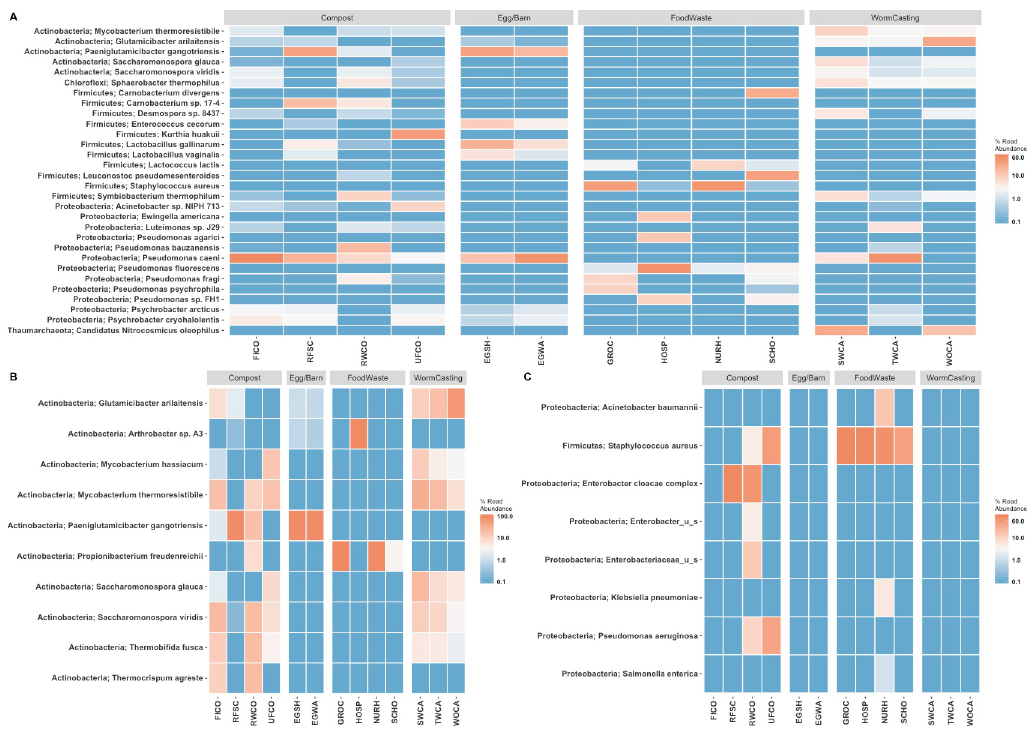
Fig 6. Heatmap of the top A) 20 bacterial species in all samples, B) members of the Actinobacteria Phylum, and C) EKSCAPE pathogens . The Phylum of each species precedes each species name. Heatmap is scaled as the log10 percent read abundance within each sample, with abundances < 0.1% all being represented as the same